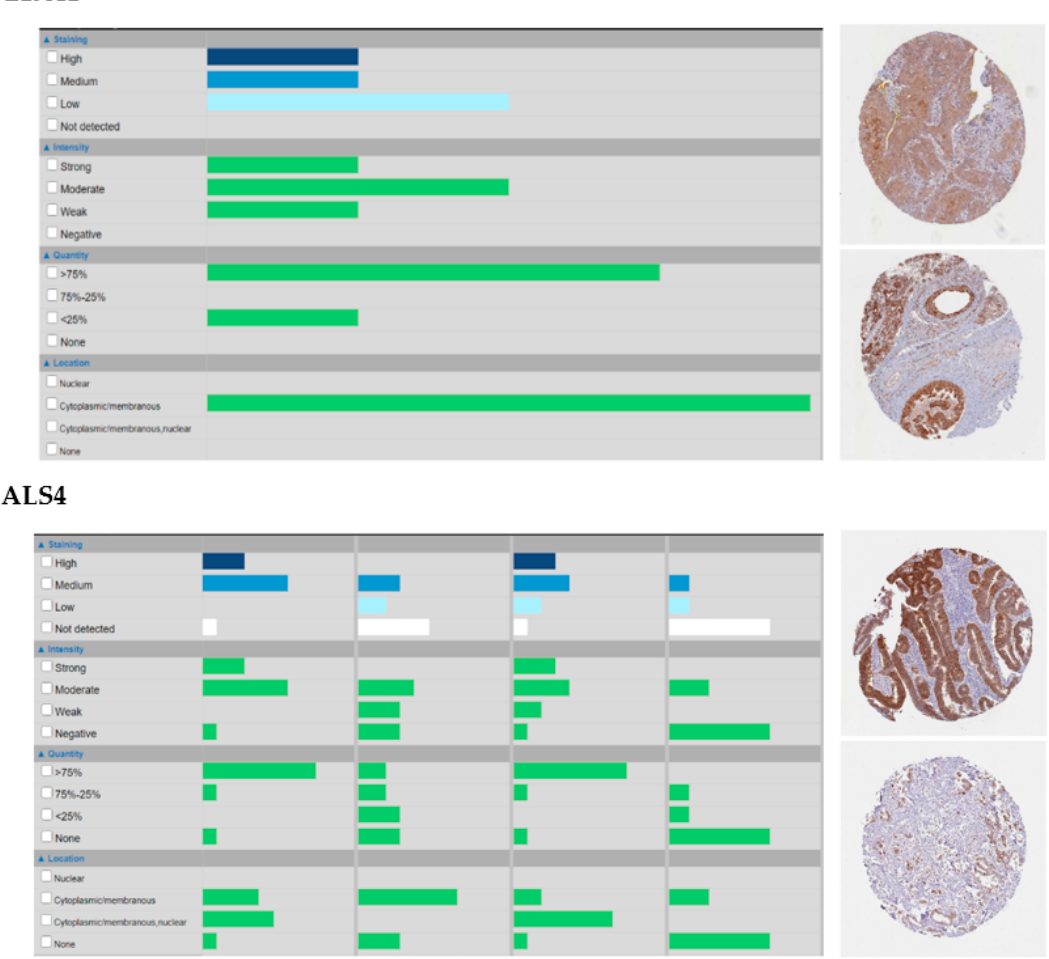
Figure A1. Patterns of staining, intensity, quantity and location, as well as examples, of COL19A1 in Head and Neck Squamous Cell Carcinoma (HNSC) and LGALS4 in STAD. Snapshots from The Human Protein Atlas (THPA, www.proteinatlas.org).